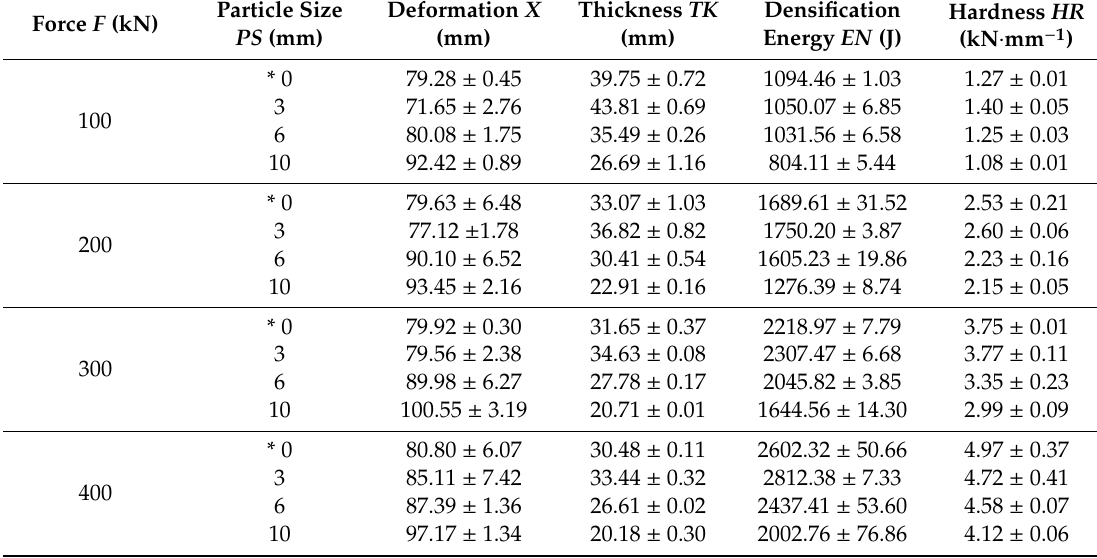
Table 7. Deformation, thickness, densification energy, and hardness of ground hazelnut husks with forces and particle size.